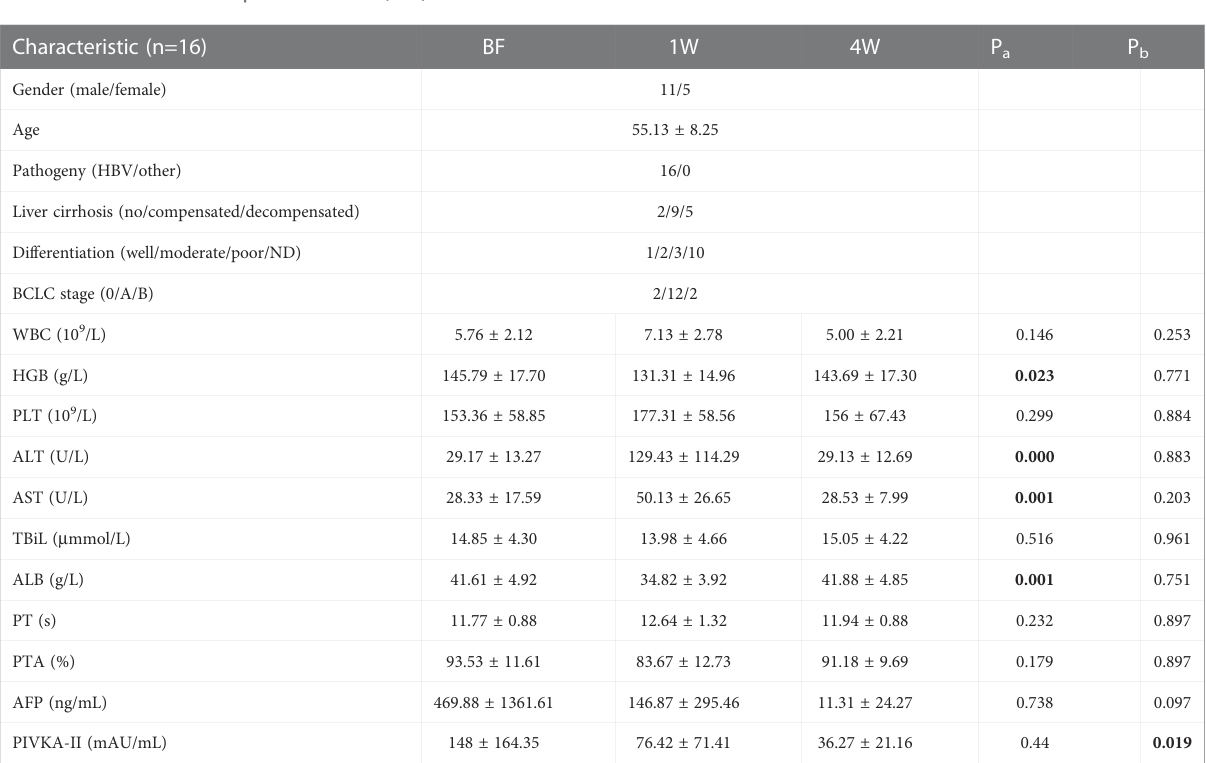
TABLE 2D Characteristics of patients in the BF, 1W, and 4W cohort.